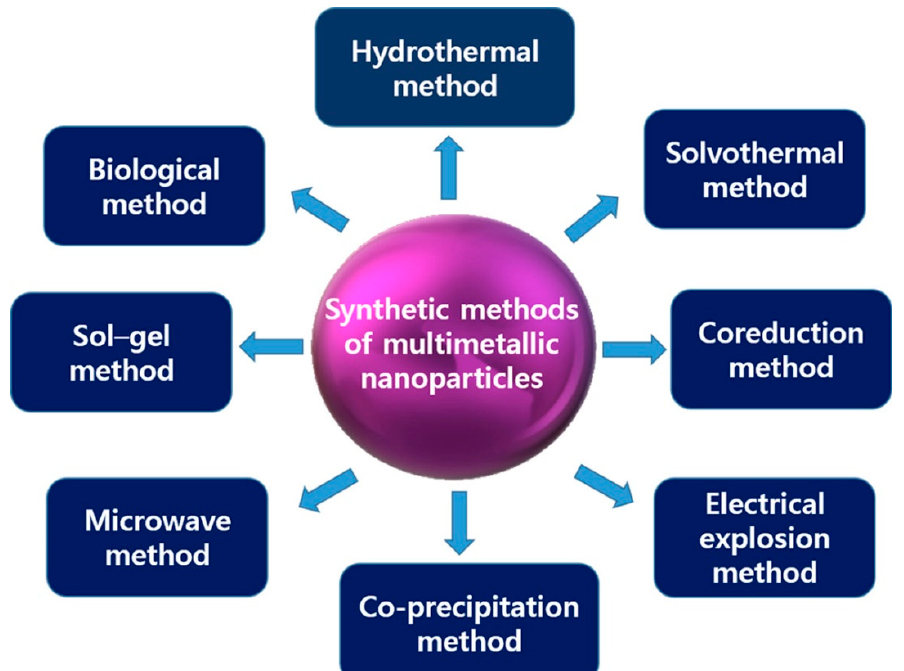
Figure 1. Synthetic methods for the preparation of multimetallic NPs.